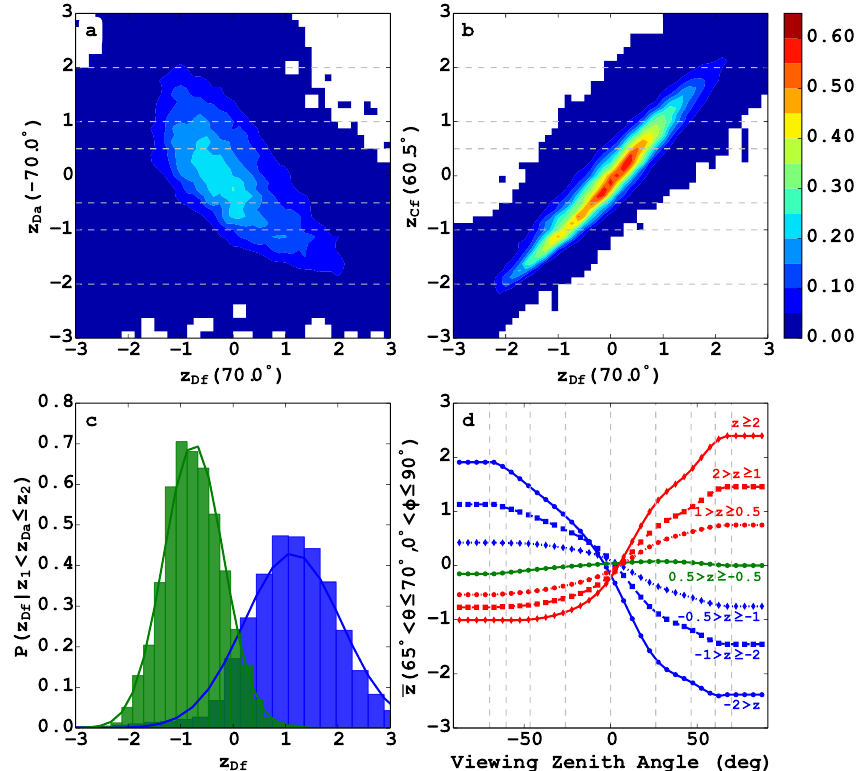
Figure 12. (a) Joint probability distribution of 0.86µm reflectance standard scores between MISR’s Df and Da cameras. The dashed lines indicate the standard score ranges used to develop adjustment factors. (b) As in (a) but for MISR’s Df and Cf cameras. (c) The Df conditional probabilities of standard score when the Da standard score is between − 1 and − 2 (blue histogram) and between 1 and 2 (green histogram). (d) Adjustment factor against viewing zenith angle for the different standard score ranges for θ = 65–70 ◦ in the forward direction. Dashed lines indicate the nine MISR camera angles. These values are used to adjust the mean CERES reflectances in order to create the ADMs.